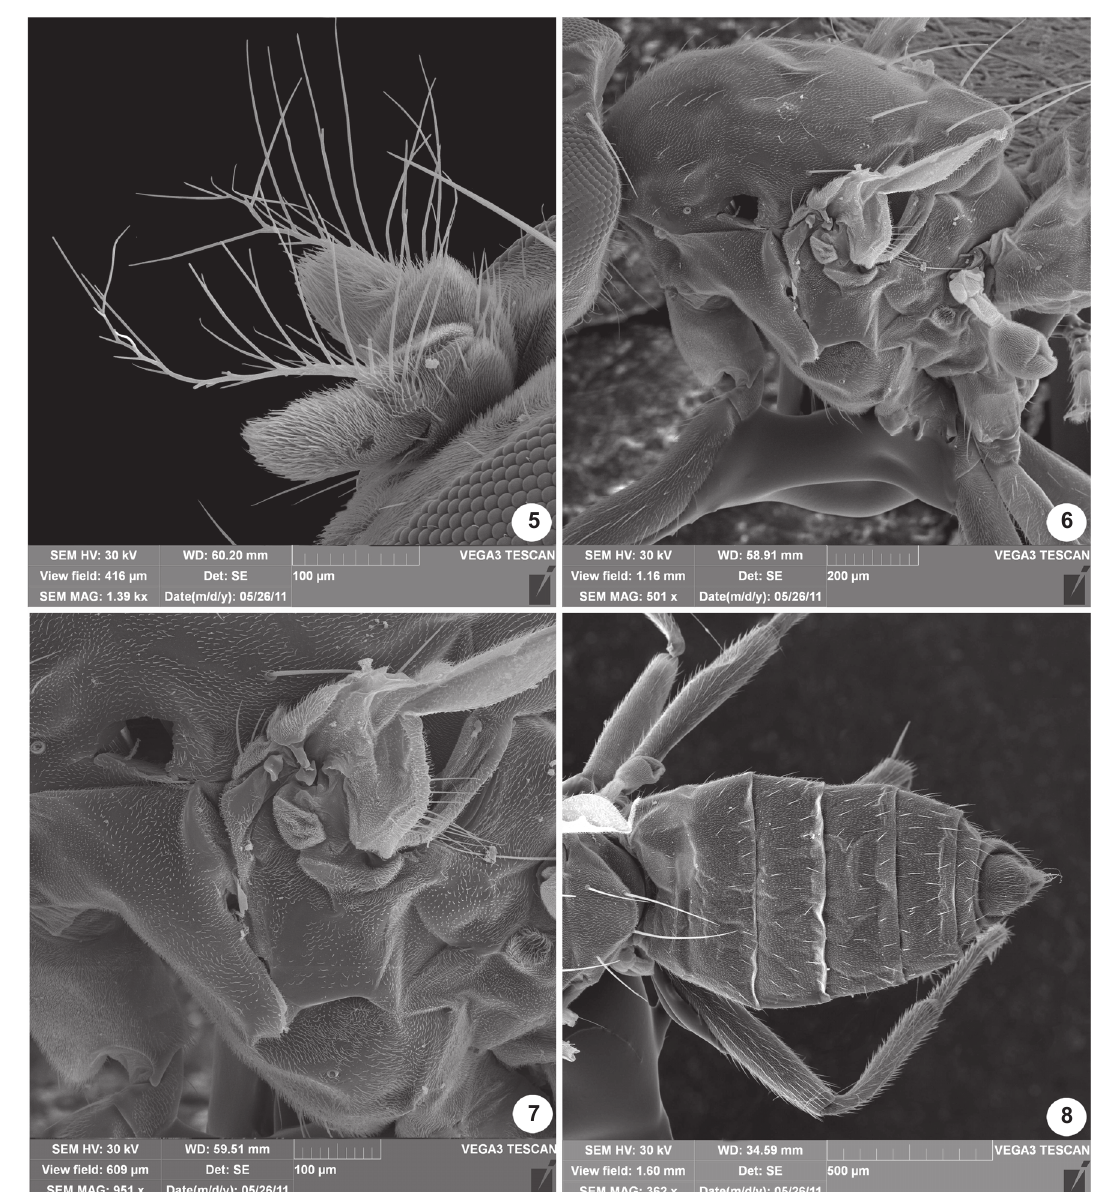
Figures 5-8. Scanning electron micrographs of Cyamops mathisi sp. nov. (female, Madagascar: Province Fianarantsoa): (5) close up of antennae, lateral view; (6) thorax, lateral view; (7) pleural region of thorax, lateral view; (8) abdomen, dorsal